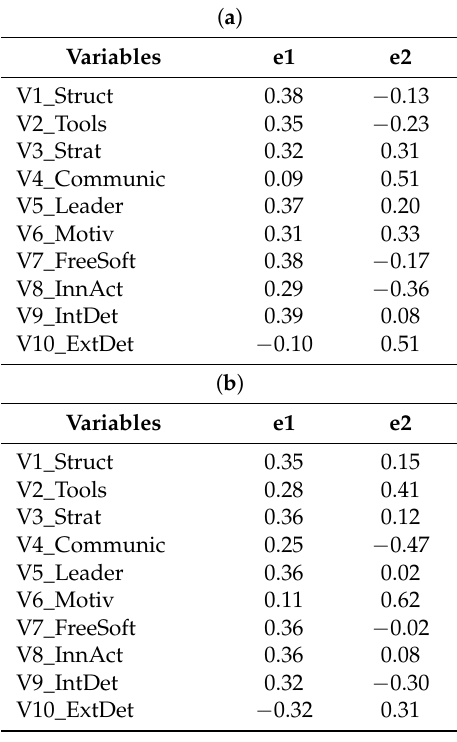
Table 5. ( a ) Eigenvectors/Analysis of Results. ( b ) Eigenvectors/Analysis of